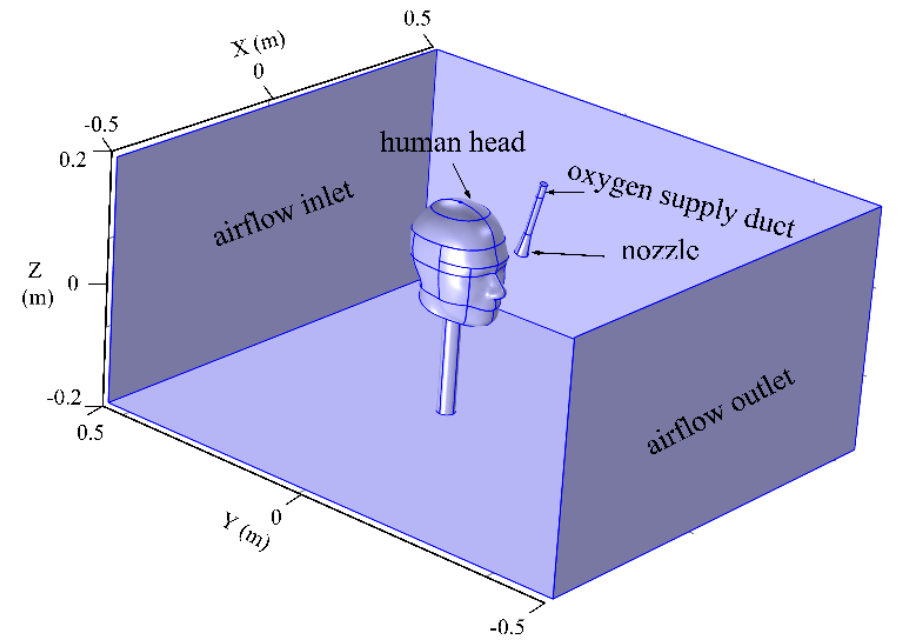
Figure 2. Physical model of individual oxygen-supply device.